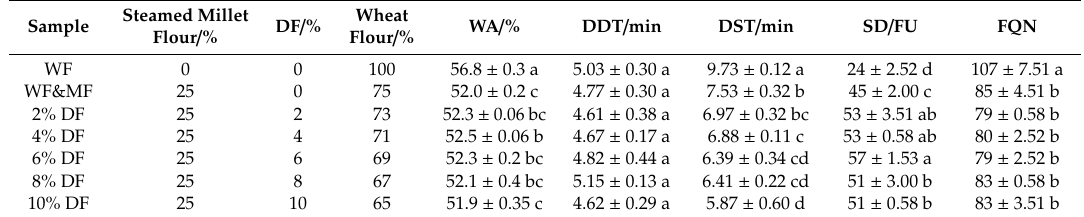
Table 1. The farinographical properties of mixed dough ( n =